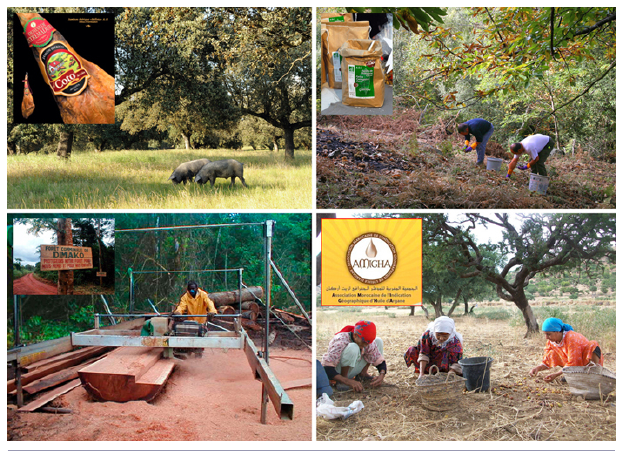
Fig. 3 . Sustainable development initiatives in rural forests: Geographical Indication for rural forest products (pork meat in the Spanish dehesa: above left, chestnut flour in Corsica: above right, argan oil in Morocco: below right) or Community Forestry in Cameroon (below